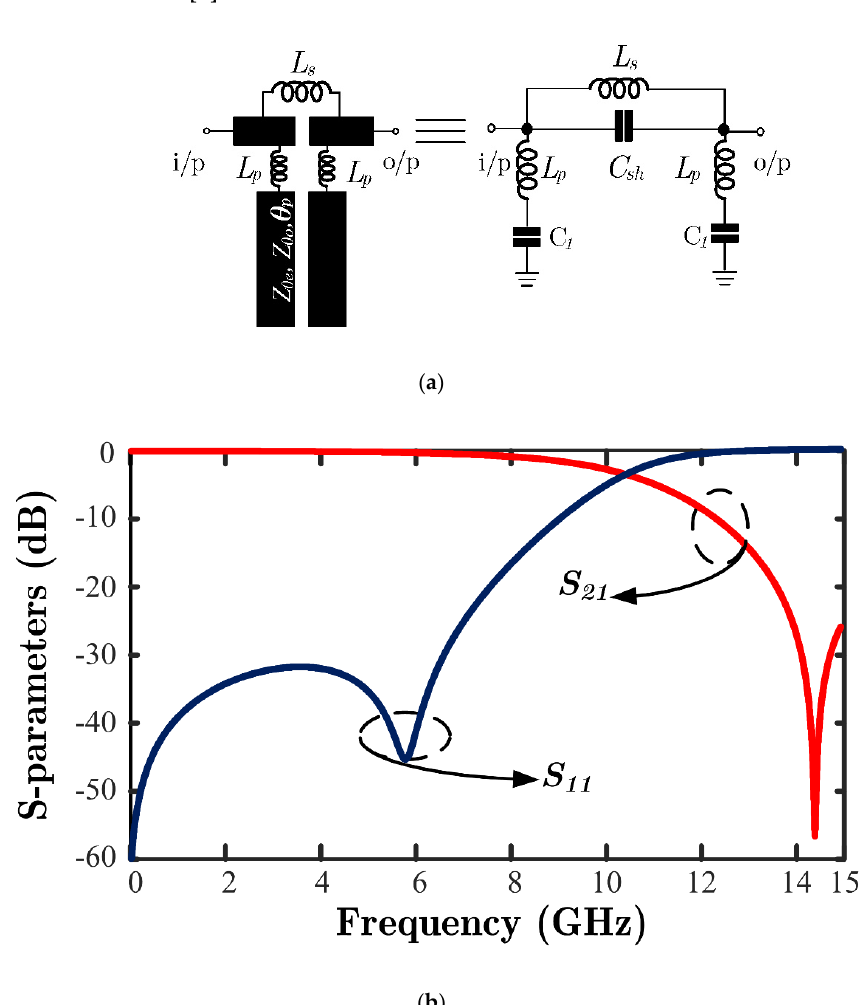
Figure 3. The design of the LPF: ( a ) Schematic of the LPF and ( b ) the frequency response of the LPF with compensated inductors ( 𝐿 (cid:3043) = 0.2 nH ) from computer